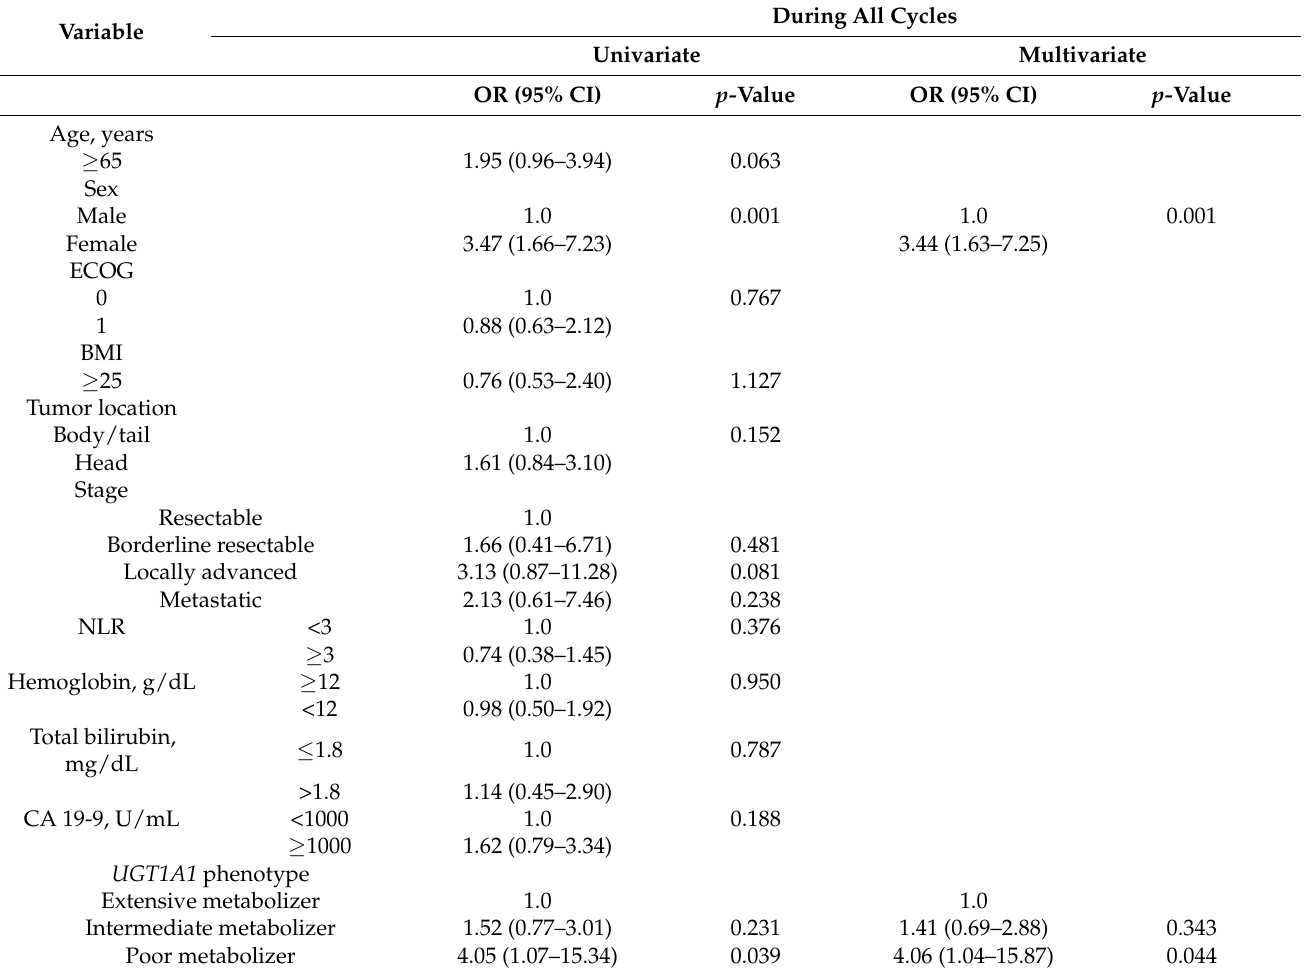
Table 5. Univariate and multivariate analysis related to grade 4 neutropenia.